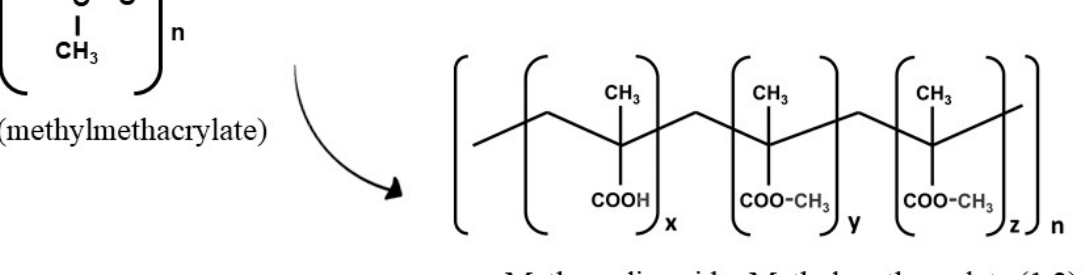
Figure 3. Representation of the PMMA chemical structure and two copolymers.